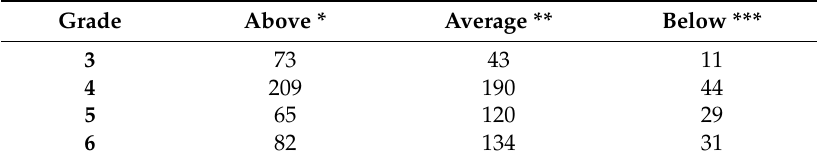
Table 3. Categorization of participants according to perceived motor skills ability and grade. Grade Above * Average ** Below *** 3 73 43 11 209 190